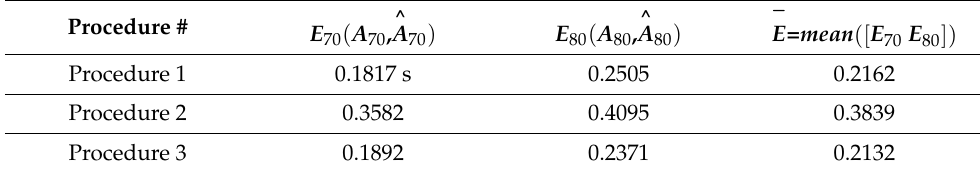
and ˆ A sp (procedures 1, 2, and 3). 1 1